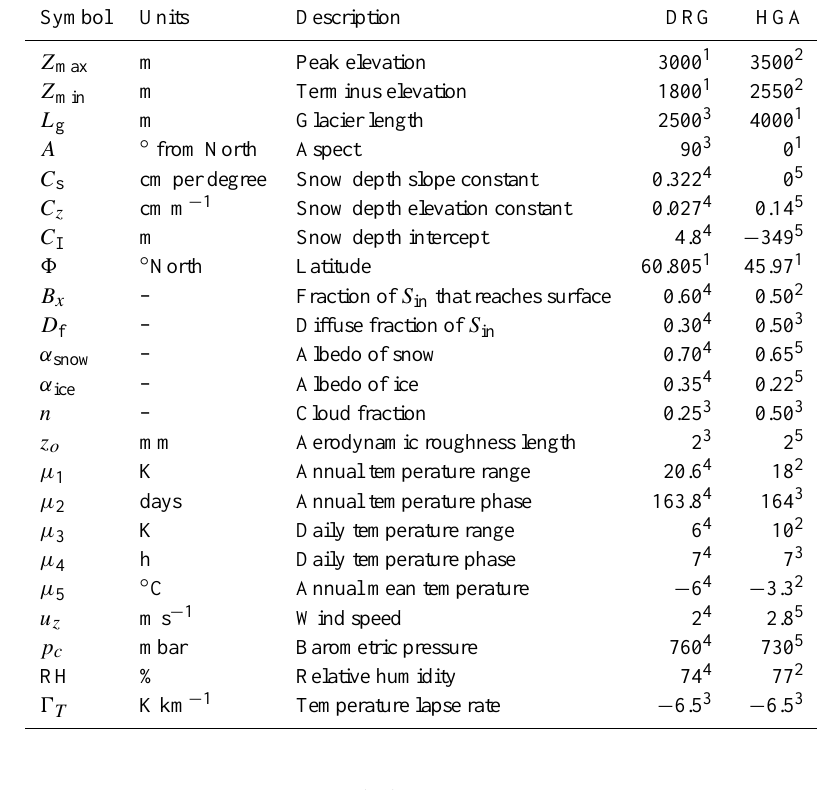
Table 4. Input parameters to the IEBM for Donjek Range glaciers (DRG) and Haut Glacier d’Arolla (HGA). Parameter sources: (1) Google Earth™ , (2) Carenzo et al. (2009), (3) arbitrary or prescribed, (4) derived from Donjek Range data, (5) Brock et al. (2000). Parameters such aspect are arbitrary for DRG and do not represent all